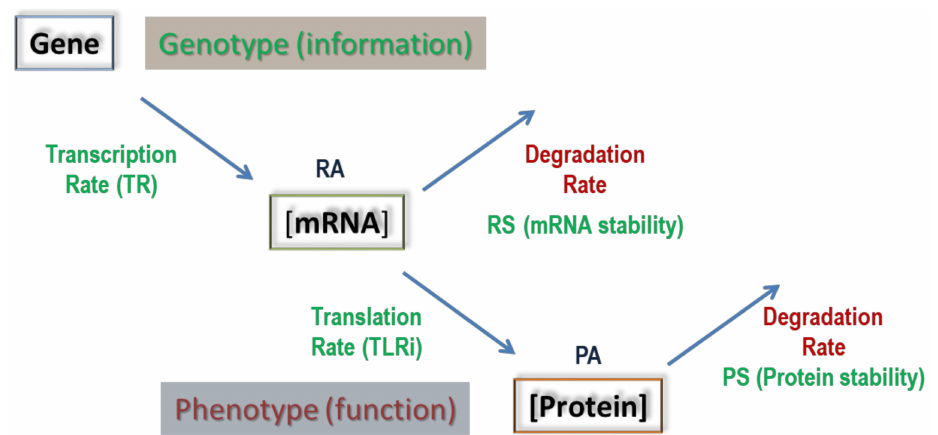
Figure 1. The six variables of the gene expression flux. The genetic information (genes = genotype) is transcribed to mRNAs, of which the concentration (RA), under steady-state conditions, depends on the equilibrium between synthesis (TR) and the degradation rates (herein expressed as the reverse parameter, mRNA stability: RS). The phenotype is, however, dependent mainly on the protein concentration (PA), which, in turn, depends on their synthesis (TLRi) and degradation rates (or stabilities, PS). See the main text for additional